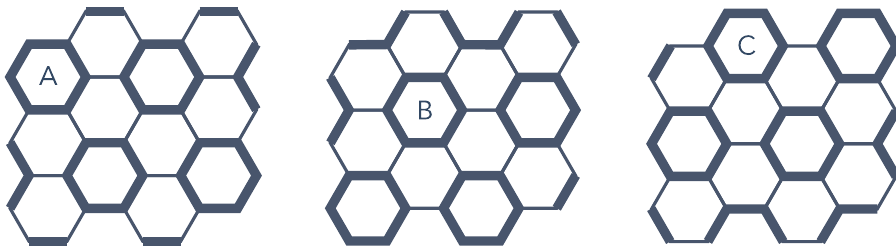
Fig. 6 The three different hexagon loop crystals. The thicker bonds show the length-six hexagons loops, which form a